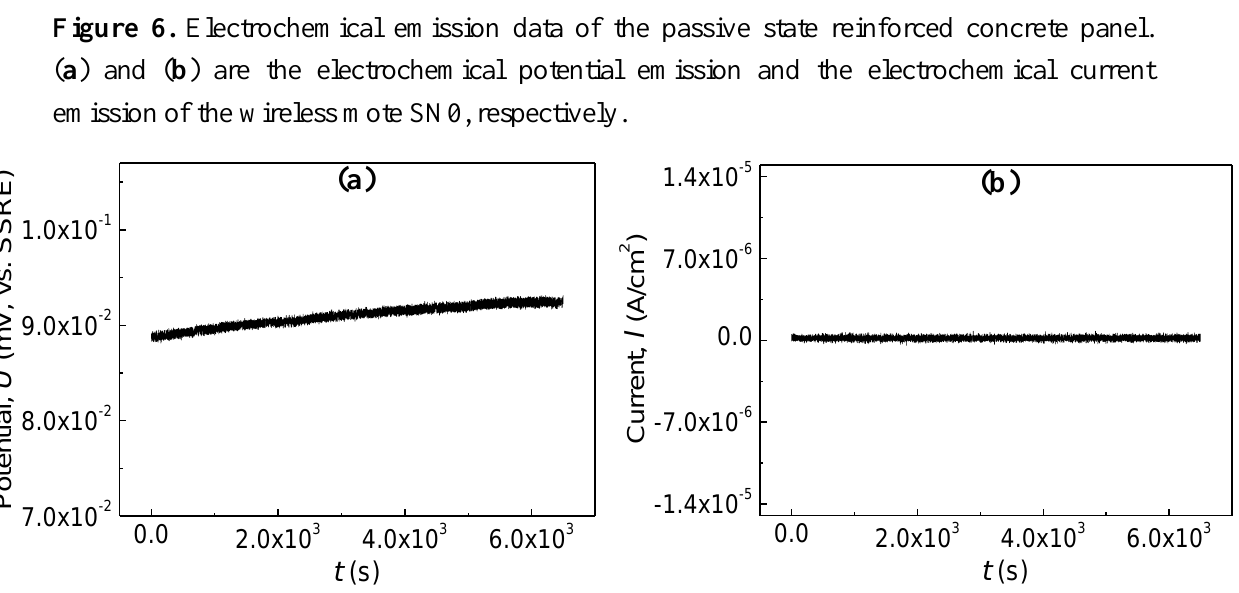
Figure 6. Electrochemical emission data of the passive state reinforced concrete